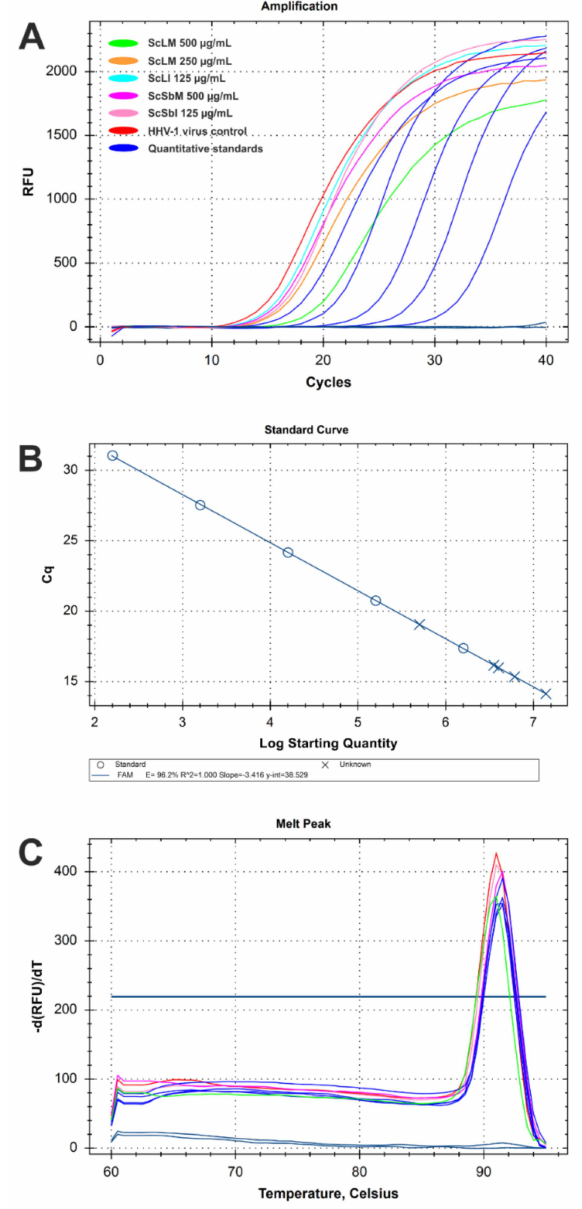
Figure 7. Real-time PCR analysis of HHV-1 viral load in virus-infected VERO cells treated with S. cam- panulata extracts: ( A )—real-time PCR amplification curves; ( B )—calibration curve for quantitative analysis; ( C )—post-amplification melt curve